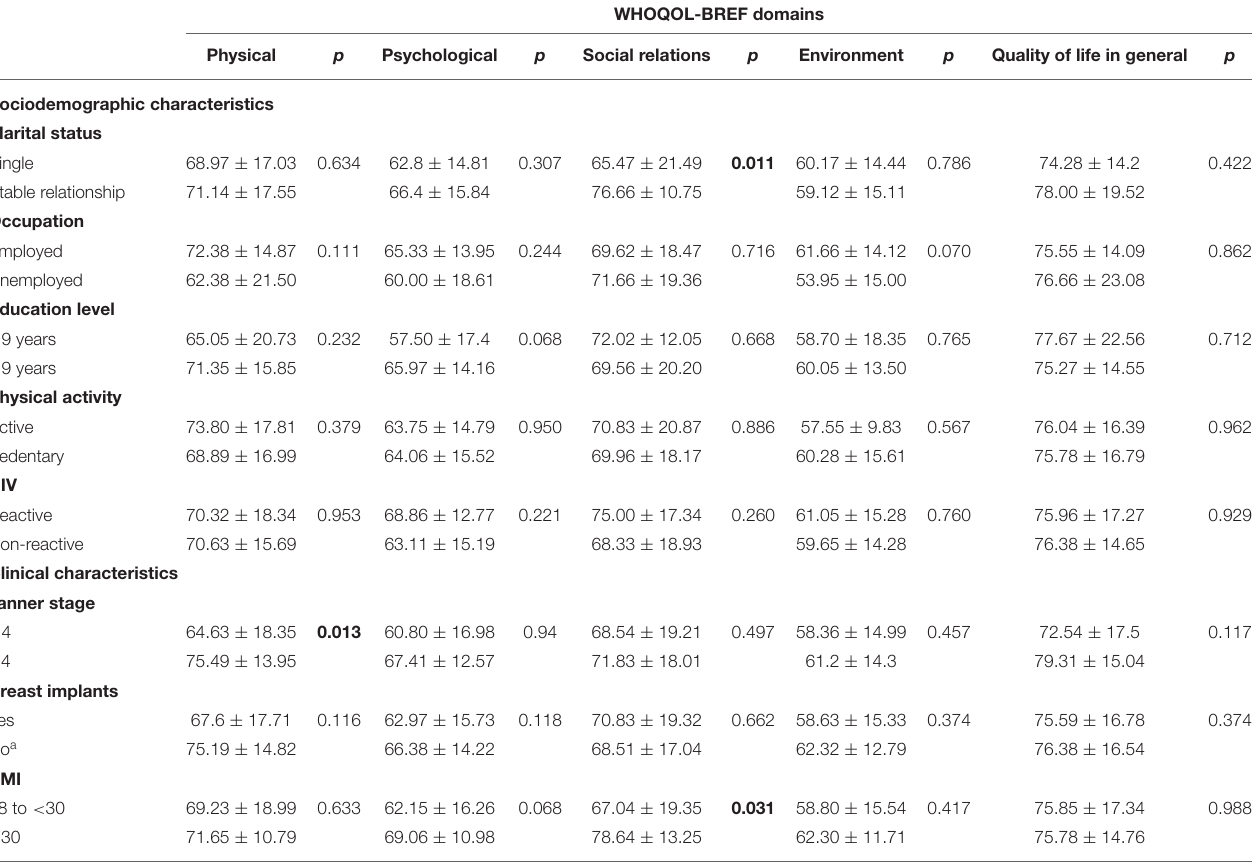
TABLE 3 | Mean WHOQOL-BREF scores in trans women according to sociodemographic and clinical characteristics ( N =